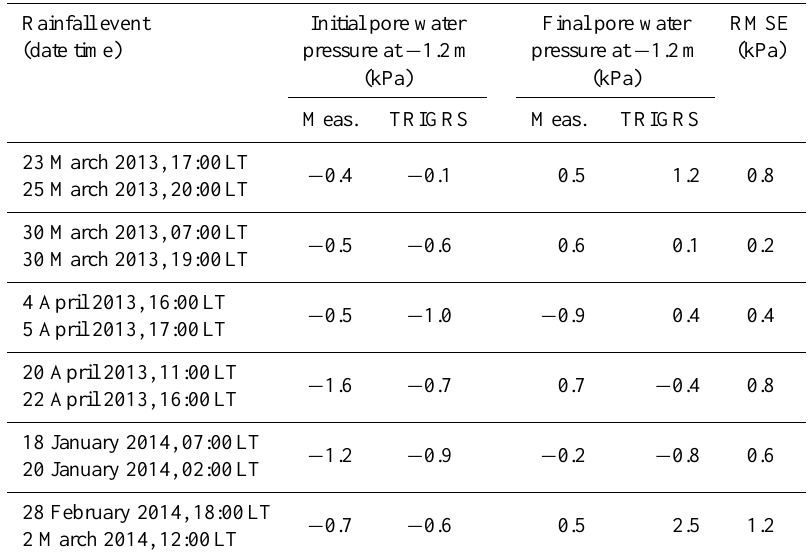
Table 8. Measured initial–final pore water pressure values versus those computed by TRIGRS-unsaturated for the selected rainfall events at 1.2m from ground corresponding to the monitoring station in the study